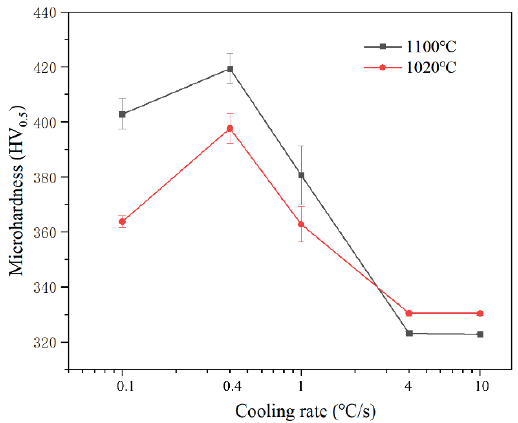
Figure 13. Microhardness versus cooling rate for Ti-22Al-25Nb alloy cooled from different regions.